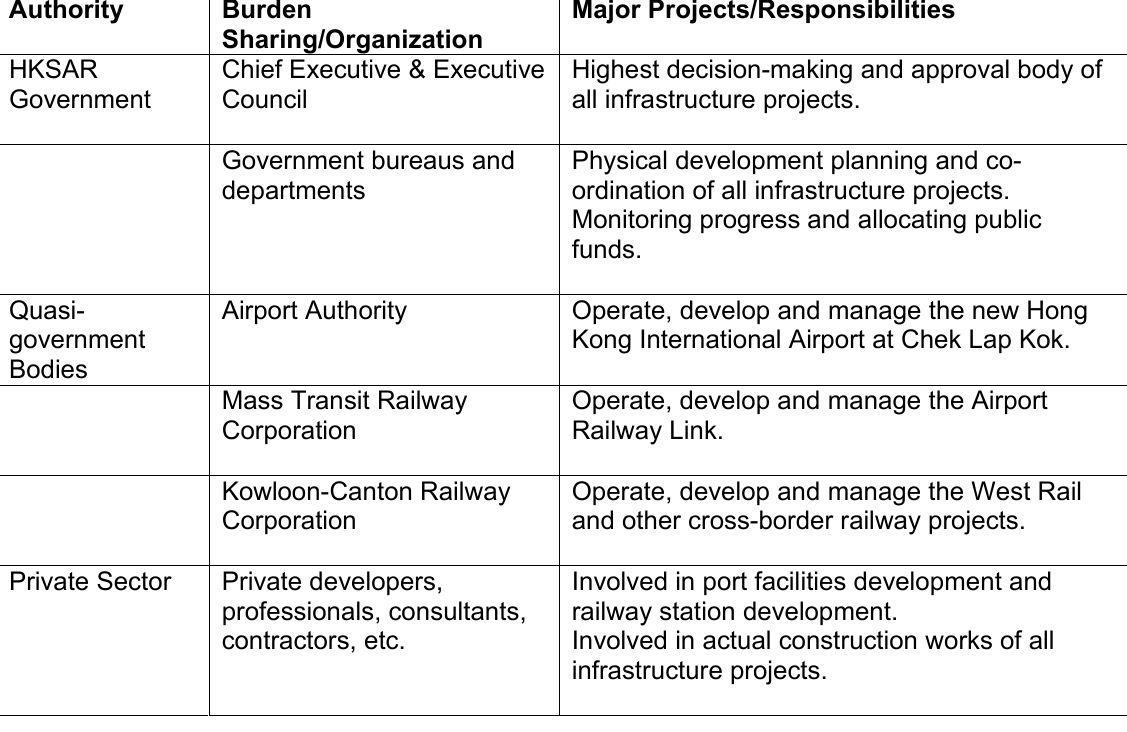
Table 2. Implementation Body and Burden-Sharing for Infrastructure Projects